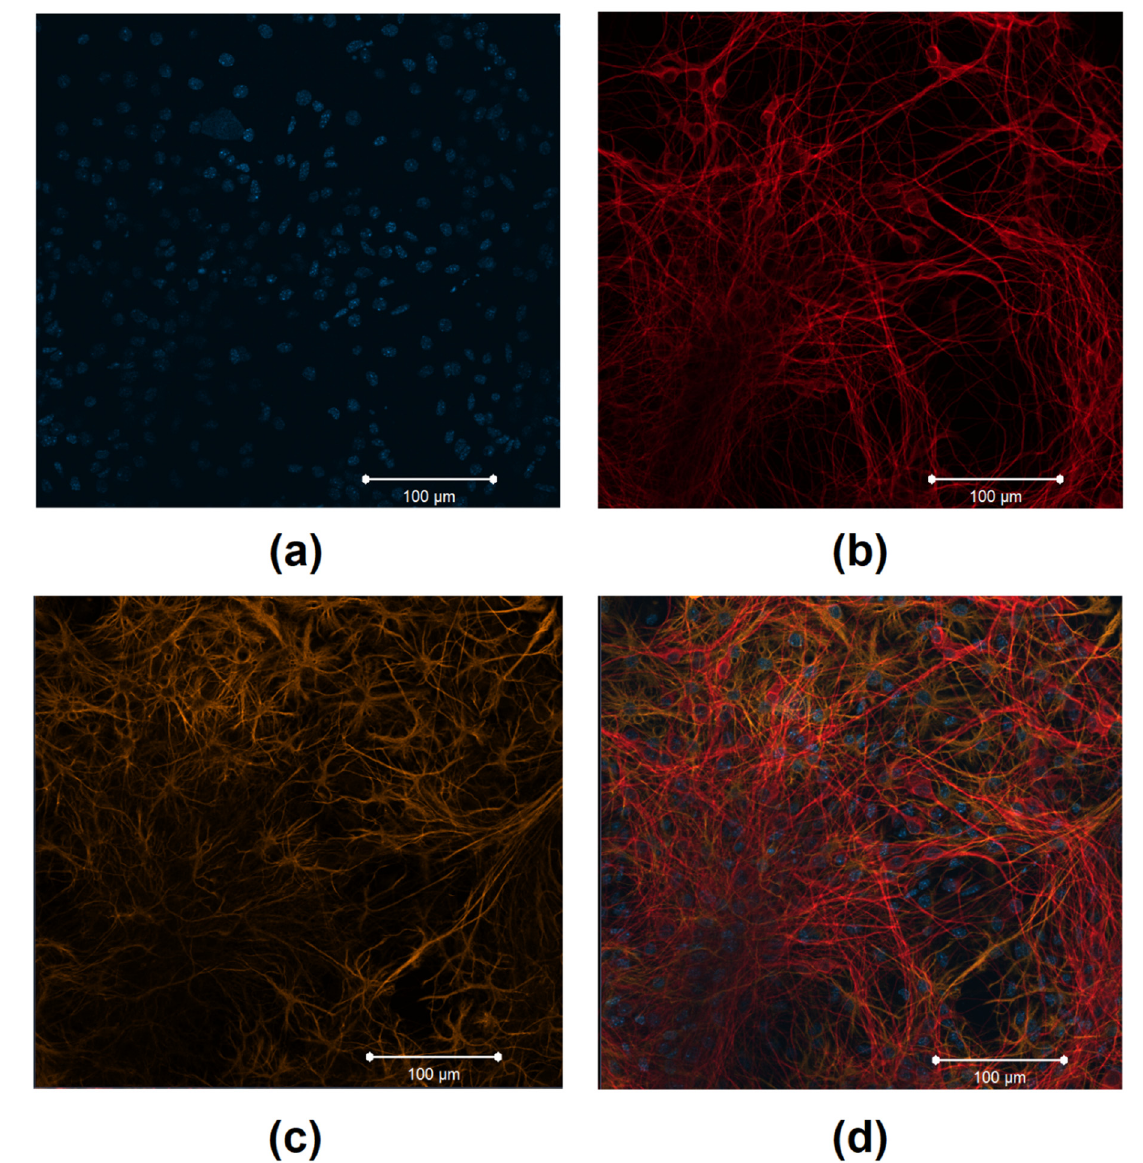
Figure 1. Immunocytochemical analysis of primary cortical cultures on day 14 of cultivation in vitro. Representative confocal images were obtained using an LSM 800 confocal laser scanning microscope (Zeiss, Oberkochen, Germany). ( a ) Fluorescence of a nuclear marker (DAPI) ( λ ex 350 nm; λ em 470 nm); ( b ) fluorescence of a marker of neuronal protein (MAP2) ( λ ex 594 nm; λ em 650–665 nm); ( c ) fluorescence of a marker of cytoskeleton protein of differentiated astrocytes (GFAP) ( λ ex 488 nm; λ em 555–580 nm); ( d ) overlay of the fluorescence channels. Scale bars: 100 μ m.